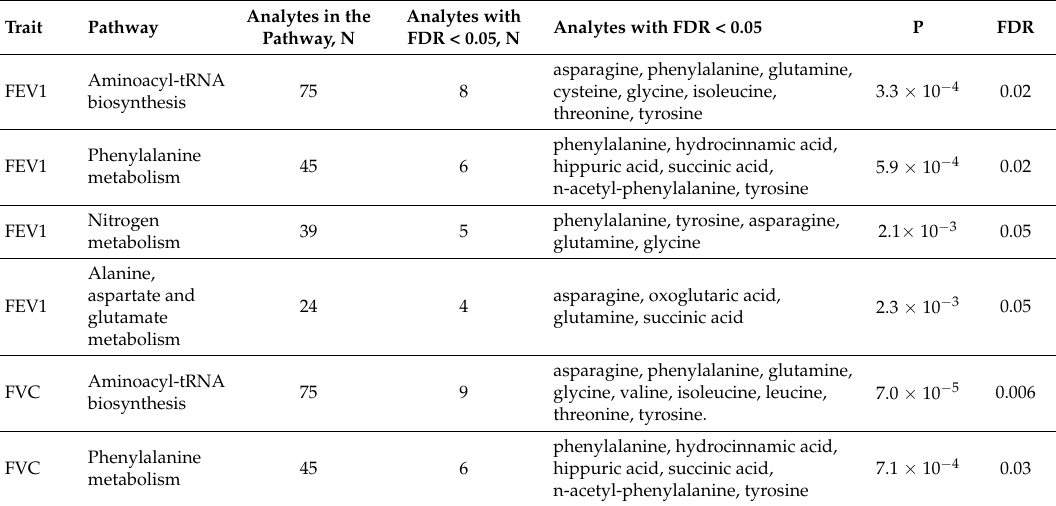
Table 5. Pathway enriched for FEV1 and FVC related